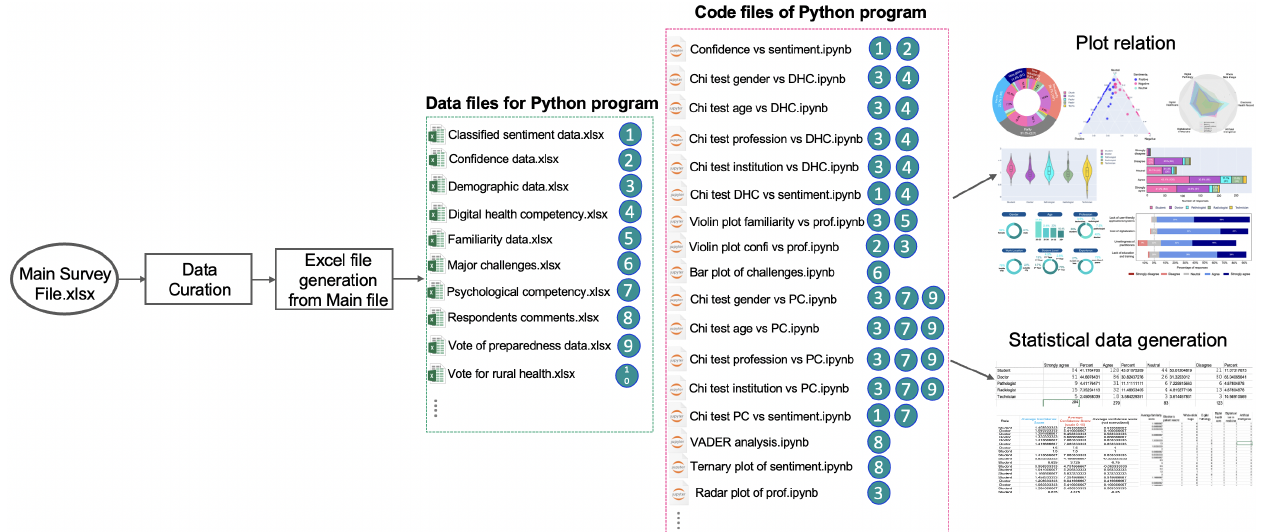
Figure 2. Overview of data